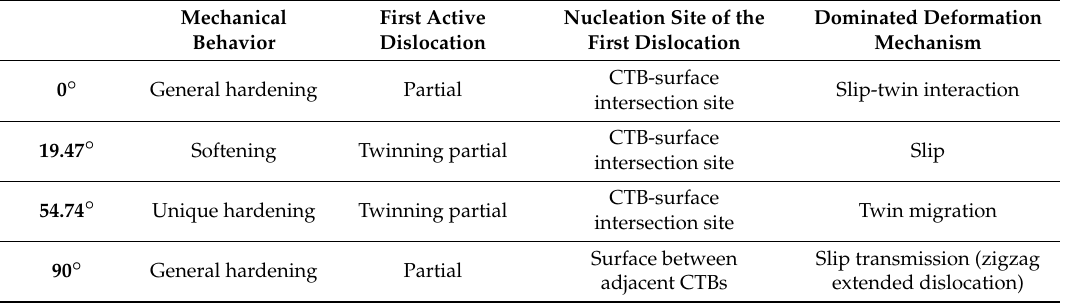
Table 2. The resulted mechanical behavior, first active dislocation and nucleation site, and dominated deformation mechanism, depending on the twin orientation angle.